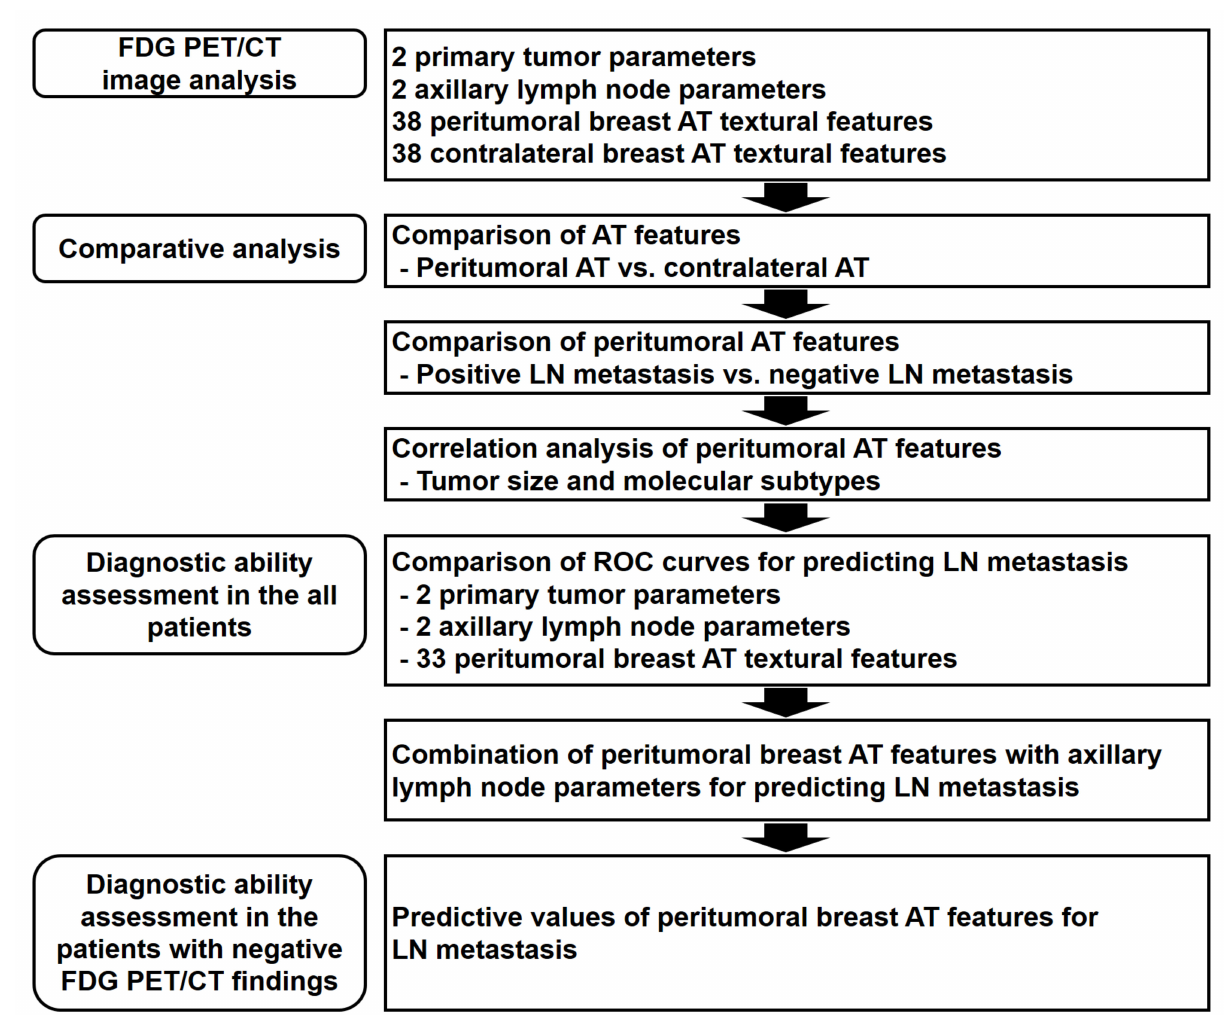
Figure 3. Schematic overview of the workflow. AT, adipose tissue; LN, lymph node; ROC, receiver operating